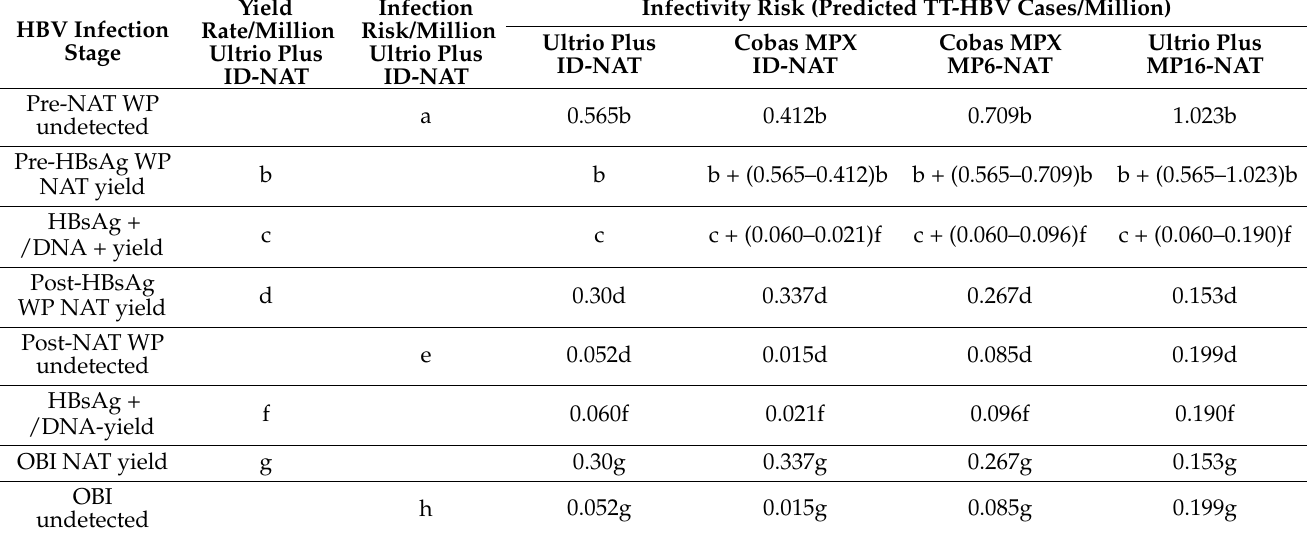
Figure 2. Schematic illustration of efficacy of HBV screening strategies in removing transmission risk. The intensity of the lower red colored bar on the bottom illustrates the infectivity of a blood component in different HBV infection stages. The line above this shows the evolution of HBV markers over time, resulting in different marker detection periods and non-detection (risk) periods, whereby the parameters b, c, d, g and f represent yield rates per million and the parameters a, e and h residual infection risk per million for the Ultrio Plus ID-NAT and serology testing strategy (see parameters a to h in Table 1). Moving upward, the next three bars above illustrate the proportion of HBV-transmissions interdicted by different screening assays whereby the infection risk of NAT and serology yield cases is assumed to be 100% in stages b and c but less in the other stages (see Table 1). The dotted line arrows indicate the efficacy in risk removal by different screening tests. Table 1. RBC transfusion-infectivity risk conversion factors for eight HBV infection stages and four NAT systems calculated by Weusten risk models [4,10] from the yield rates detected by Ultrio Plus ID-NAT and serology. The same infectivity factors are presented as a percentage of the WP and OBI ID-NAT yield rates in Supplementary Table S3, previously published as Table 4 of a recent publication of this multi-center study